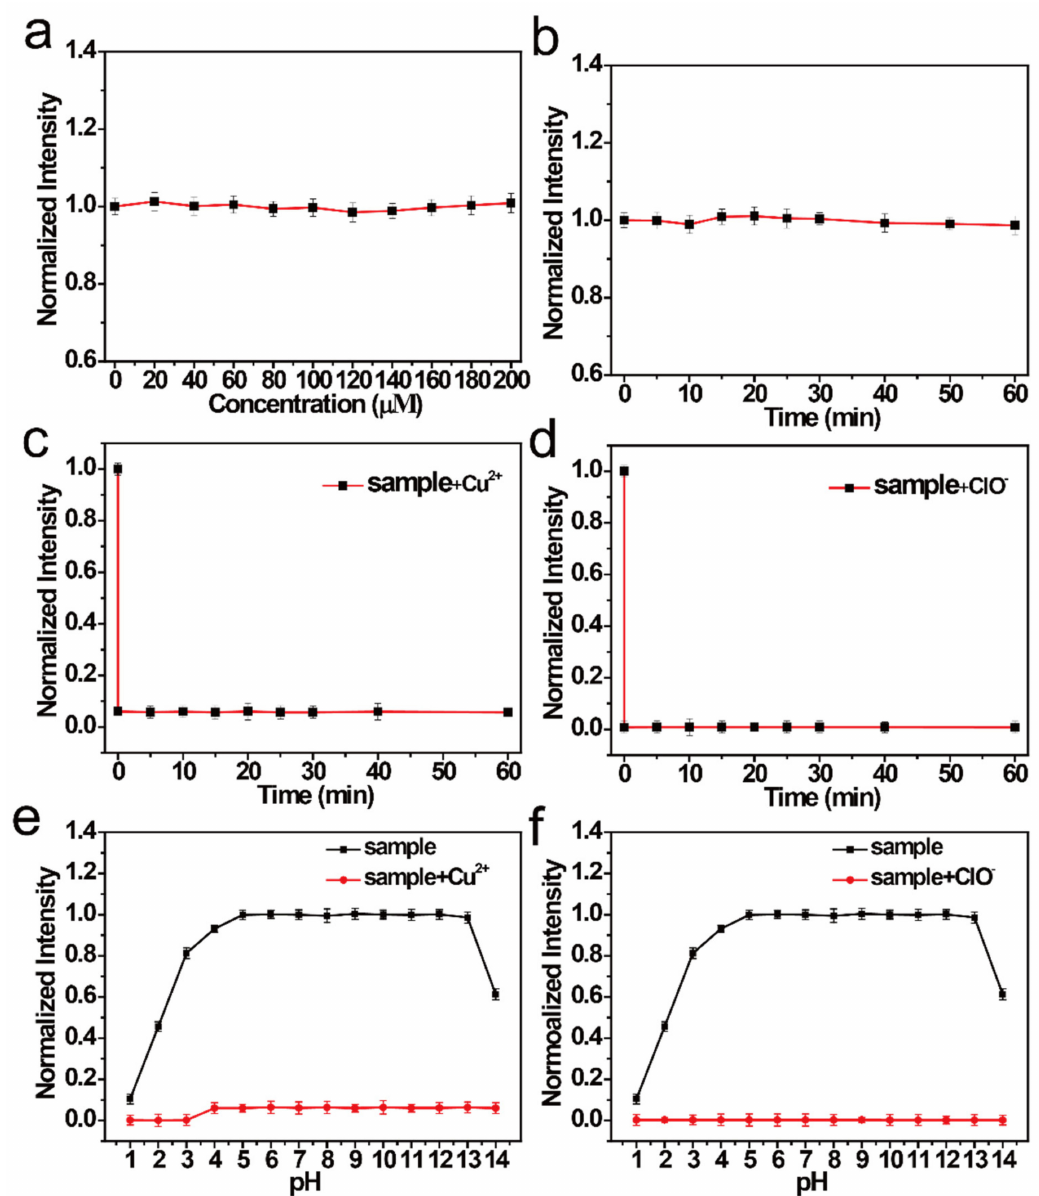
Figure 2. ( a ) Normalized FI of NCDs with different concentrations of NaCl. ( b ) Normalized FI of NCDs at different durations under UV light irradiation. Normalized FI of NCDs ( c ) with Cu 2+ and ( d ) with ClO − at different response times. Normalized FI of NCDs under different pH values ( e ) with or without Cu 2+ and ( f ) with or without ClO −